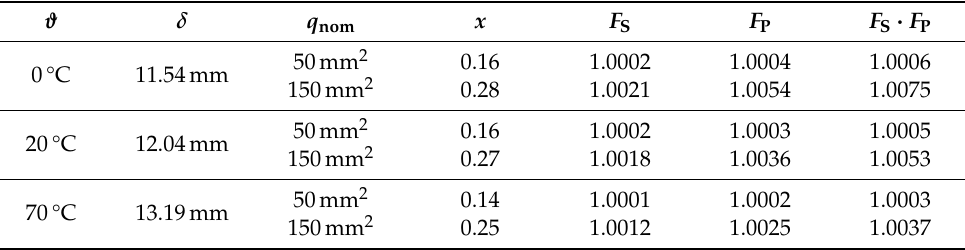
Table 6. Evaluation of skin and proximity effect factors for f = 50Hz and µ = µ 0 , approximated for aluminum sector